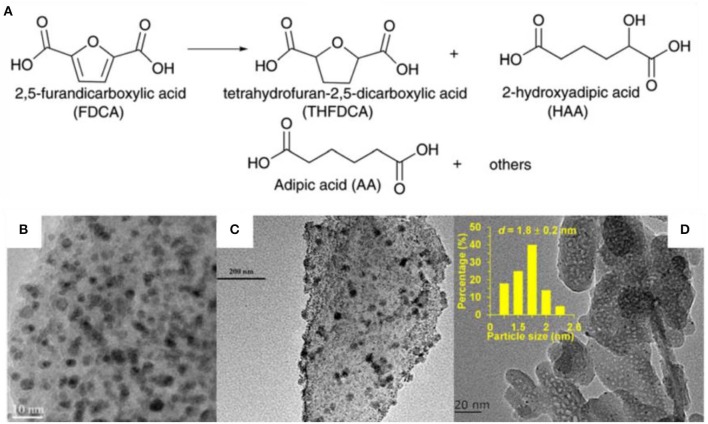
(A) HMF to AA, (Lee et al., 2016) TEM images of (B) AuPd/CaMgAl, (Gao et al., 2017) (C) Pt-Ni/AC, (Shen et al., 2018) (D) Ru/HAP (Gao et al., 2018).